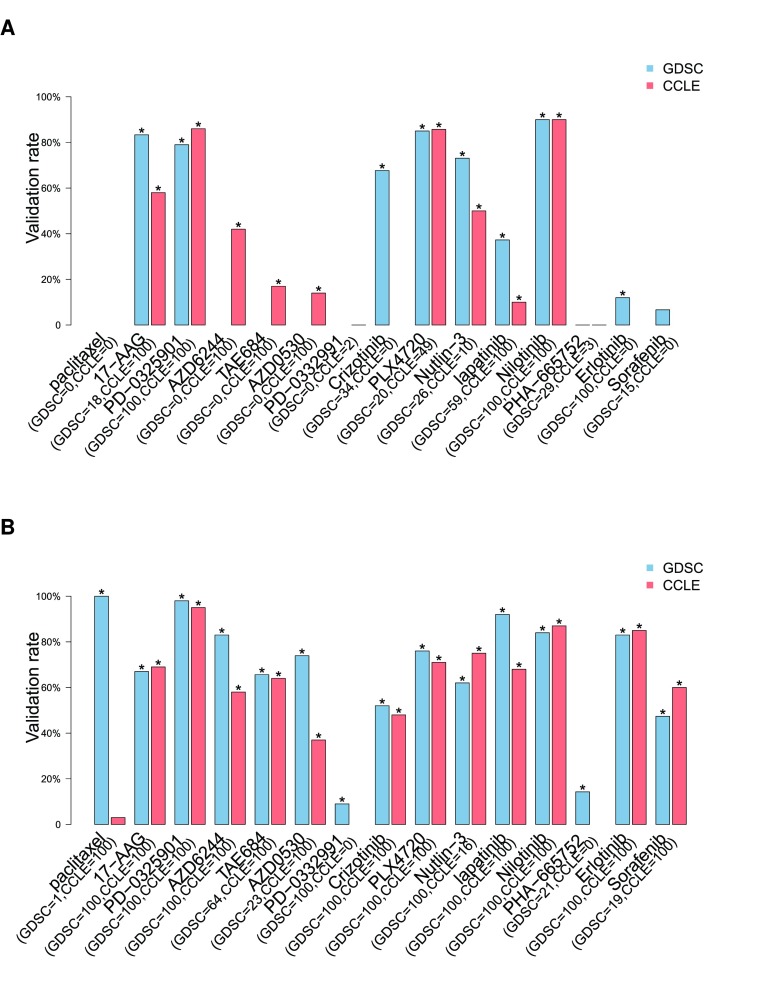
Proportion of gene-drug associations identified in a discovery set (top 100 gene-drug associations as ranked by p-values and FDR < 5%) and validated in an independent validation dataset.In blue and red are the gene-drug associations identified in GDSC and CCLE, respectively. Associations are identified using molecular profiles including gene expression, mutation and copy number variation data as input and (
A) continuous published AUC values as output in a linear model using only common cell lines or (
B) all cell lines. The number of selected gene-drugs associations in each datasets is provided in parentheses. The symbol ’*’ represents the significance of the proportion of validated gene-drug associations, computed as the frequency of 1000 random subsets of markers of the same size having equal or greater validation rate compared to the observed rate.